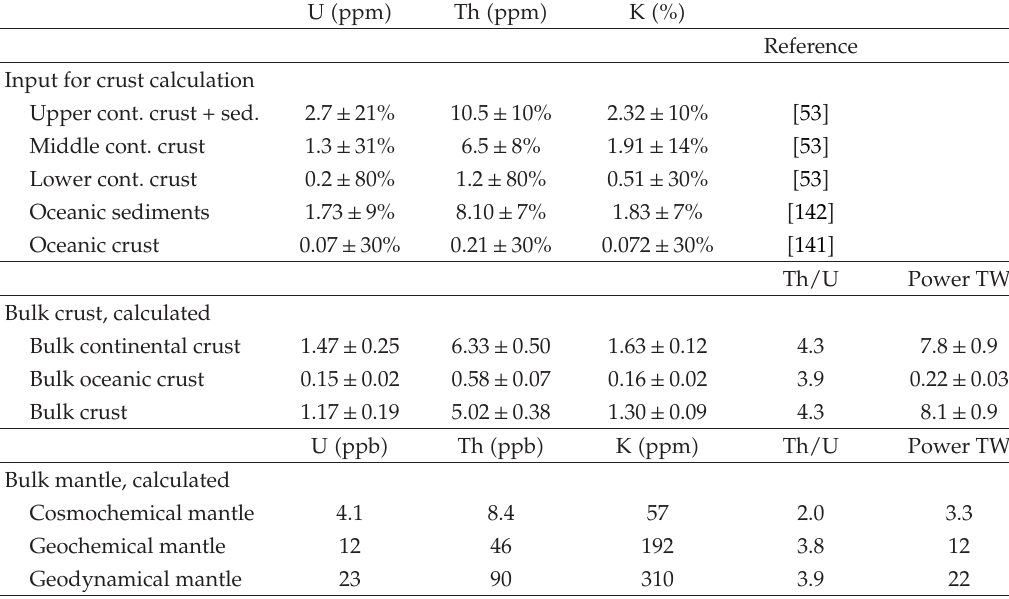
Table 7: HPE abundances used in calculation of the global crustal flux in Figure 8 and calculated abundances for the bulk crust and bulk mantle.